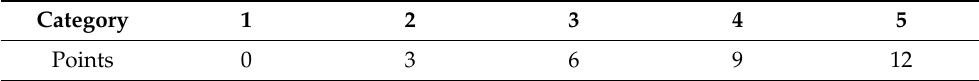
Table 4. Corresponding evaluation scores of evaluation index categories.